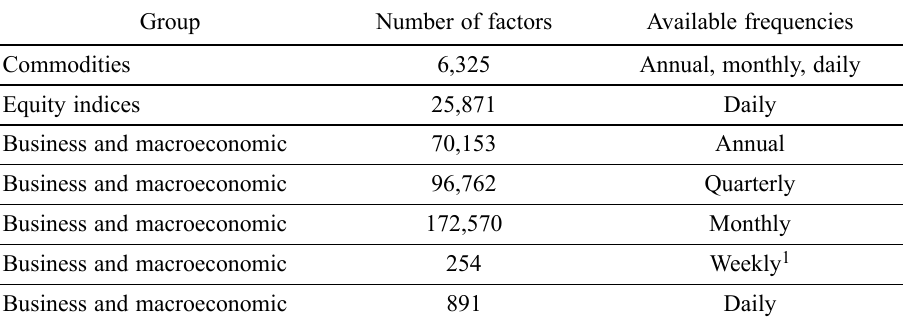
Table 1. Factors analyzed by group and available data frequencies